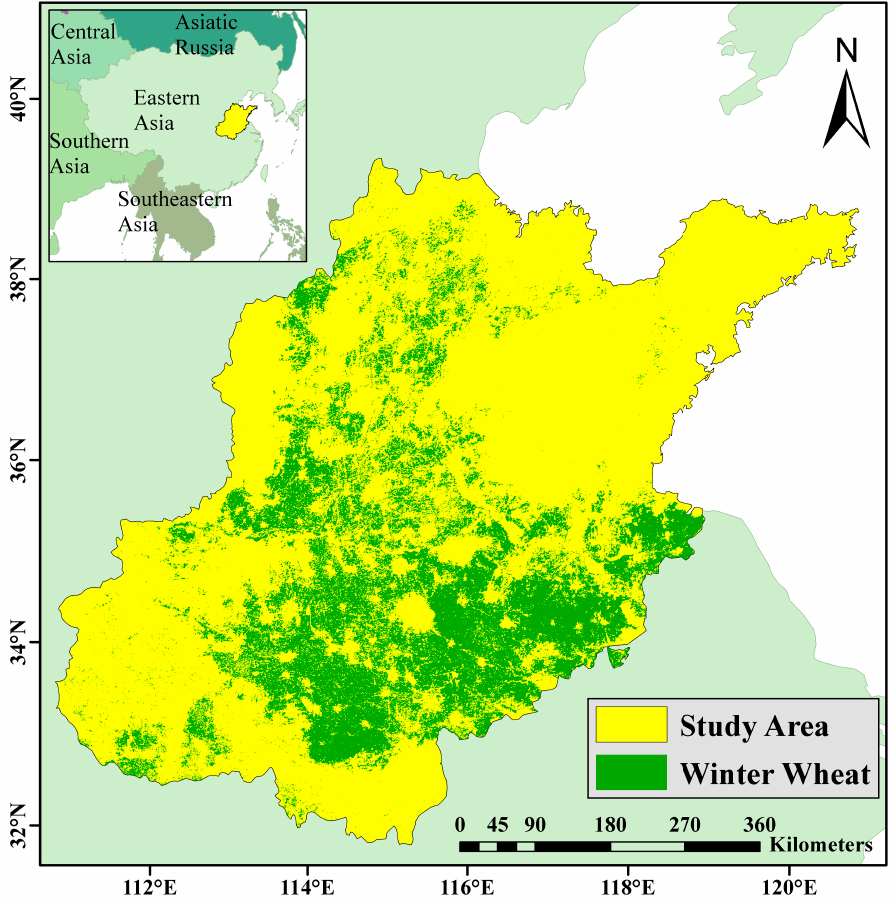
Figure 1. Location of the North China Plain (NCP) (highlighted in yellow). The green pixels represent the locations of winter wheat fields in the harvest year 2018. The base map is the regions of the